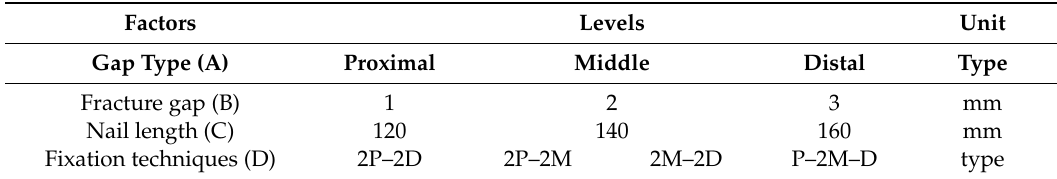
Table 4. Four locking screws: the multilevel factorial design of relevant factors and their levels. (Number of levels: 3, 3, 3, and